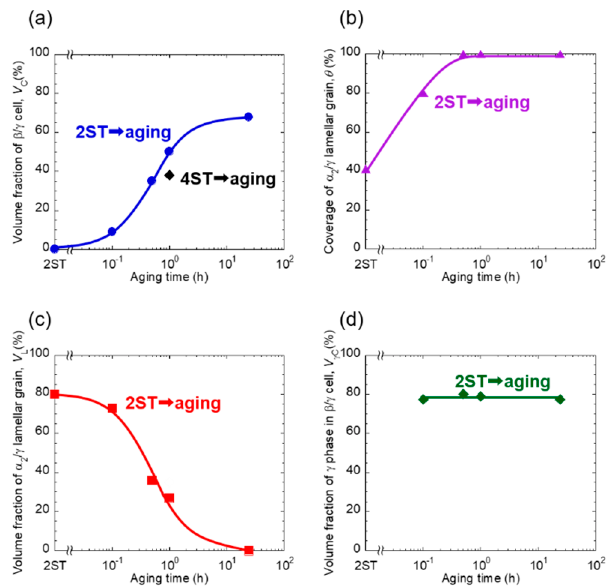
Figure 4. Variations in V C ( a ), θ ( b ), V L ( c ), and V γ C ( d ) as a function of aging time. Schematic illustrations of microstructural evolution during solution/aging